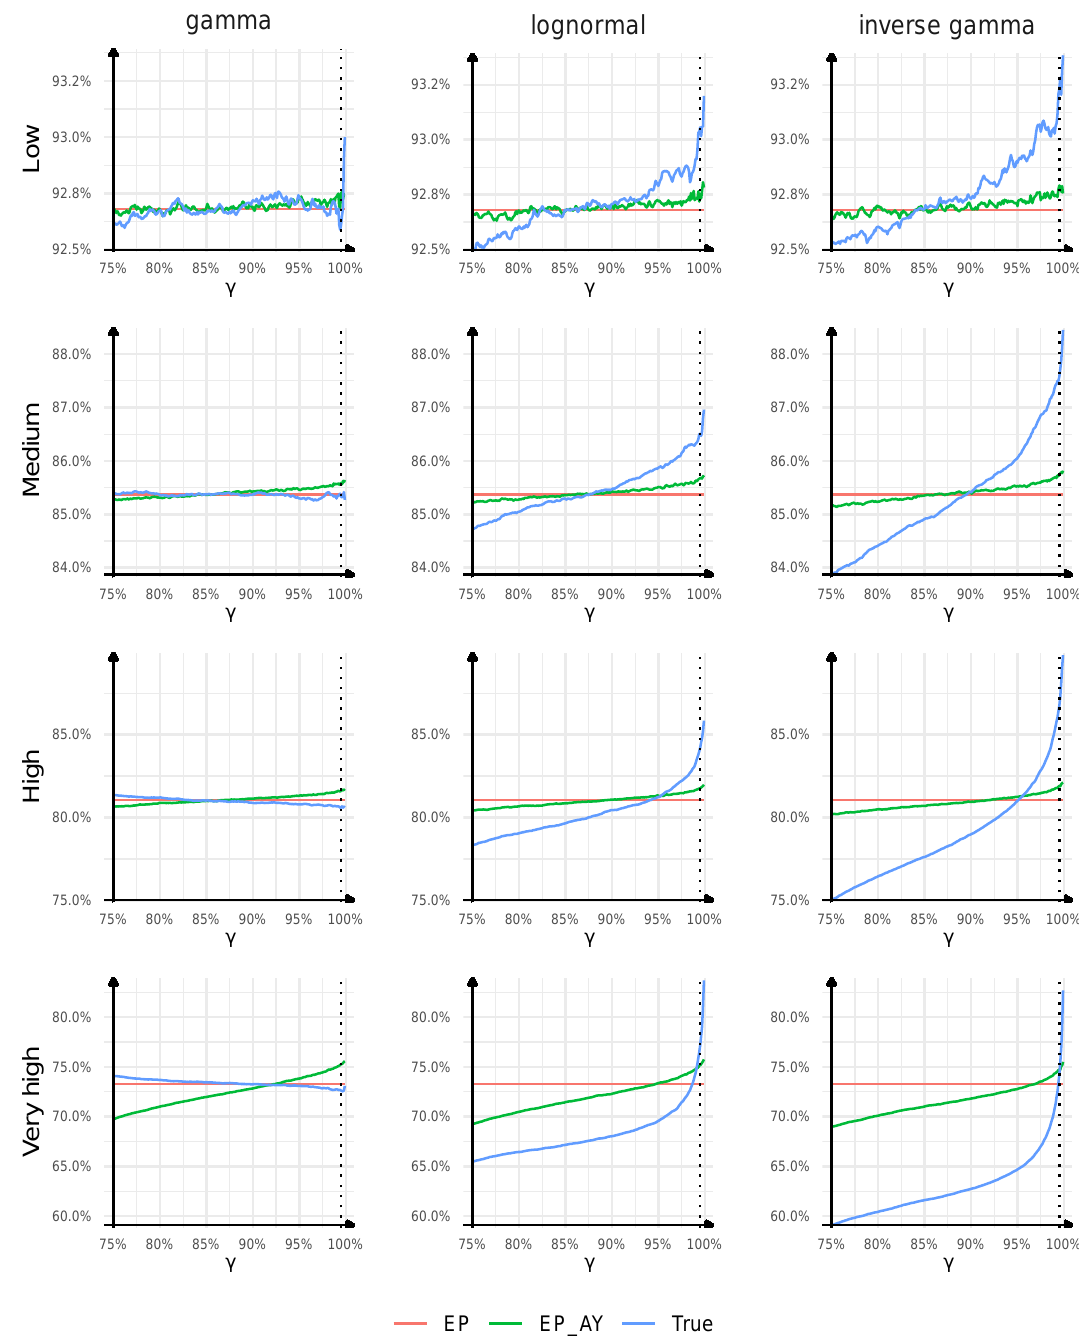
Figure 1. The ratios of Value-at-Risk measures for the one-year risk and the ultimate risk as a function of the confidence level—the case without the estimation